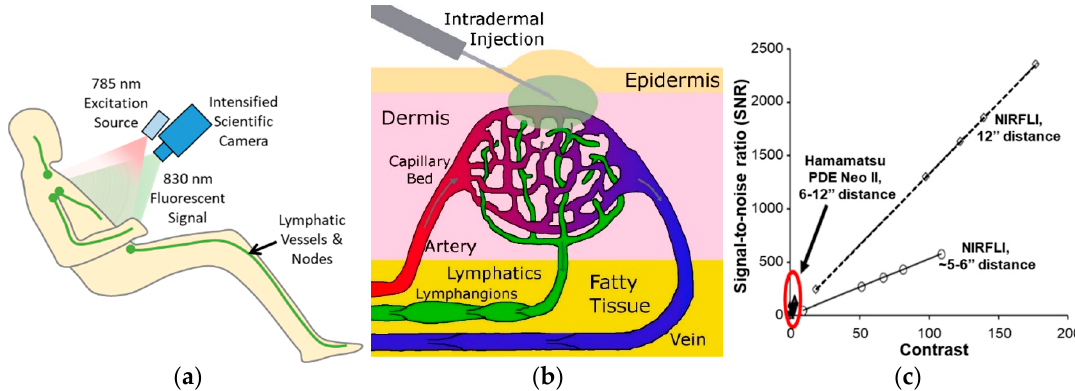
Figure 3. ( a ) Schematic of the imaging device and the typical lymphatic drainage patterns in humans. ( b ) Schematic of the dermal lymphatic vasculature and its relationship to the blood vasculature as well as the indirect delivery of contrast agent to the lymphatic plexus via intradermal injection. ( c ) Plot of the signal-to-noise ratio and contrast of the custom near-infrared fluorescence lymphatic imaging (NIRF-LI) device and a Hamamatsu PDE Neo II commercially available device.